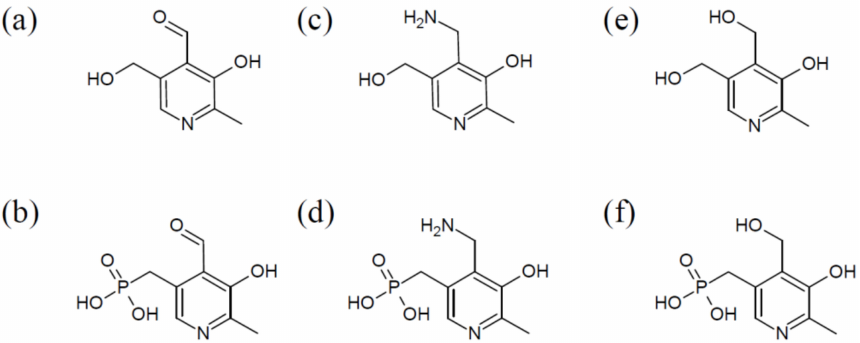
Figure 1. Chemical structures of the six common B 6 vitamers. ( a , b ): Pyridoxal ( a ) and its phosphorylated form pyridoxal 5 (cid:48) -phosphate ( b ), ( c , d ): pyridoxamine ( c ) and pyridoxamine 5 (cid:48) -phosphate ( d ), ( e , f ): pyridoxine ( e ) and pyridoxine 5 (cid:48) -phosphate ( f ).